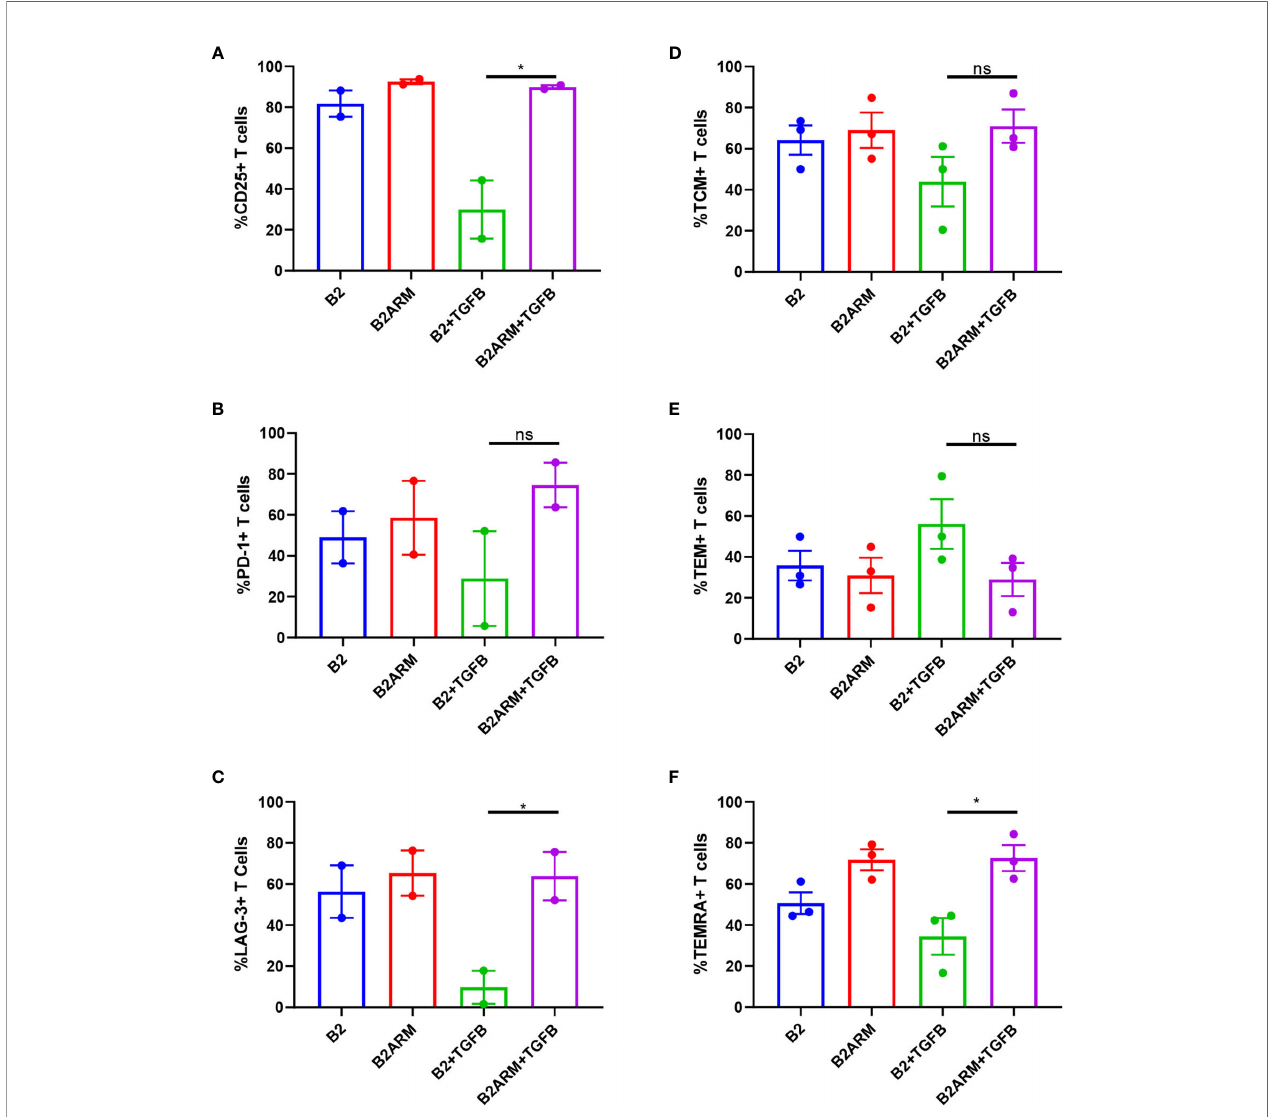
FIGURE 6 | The activation and differentiation capacity of the B2ARM CAR T-cells is not inhibited by TGF- b . Cell surface expression of (A) CD25, (B) PD-1, (C) LAG- 3 on CD3+ cells co-cultured with MM.1S were assessed by fl ow cytometry on day 8 during the second round of co-culture with MM.1S cells in the presence or absence of TGF- b . The percentages of central memory (D) , effector memory (E) , and TEMRA (F) T-cell subsets were determined by the expression of CD62L on CD3+CD45RO+ and CD3+CD45RA cells. Mean values±SEM of 2 to 3 donors from different experiments are shown. Statistically signi fi cance was determined Student t-test. *p<0.05, ns-non-speci fi